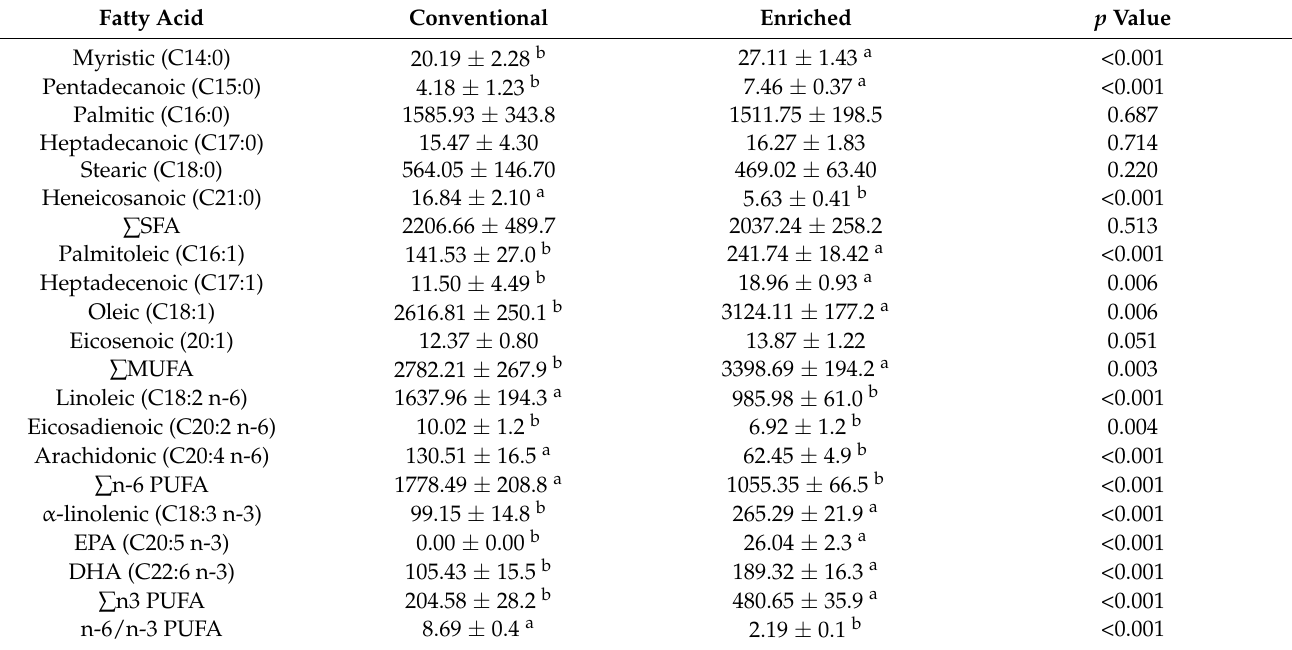
Table 7. Fatty acid profile in egg yolks (mg FA/100 g of eggs).